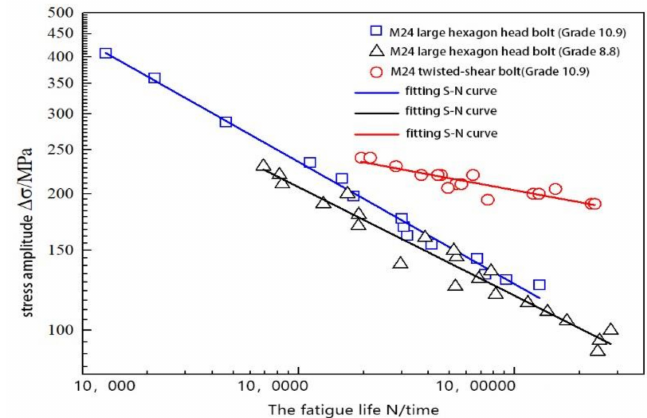
Figure 11. Comparing fatigue test results of three bolts (double logarithmic S-N